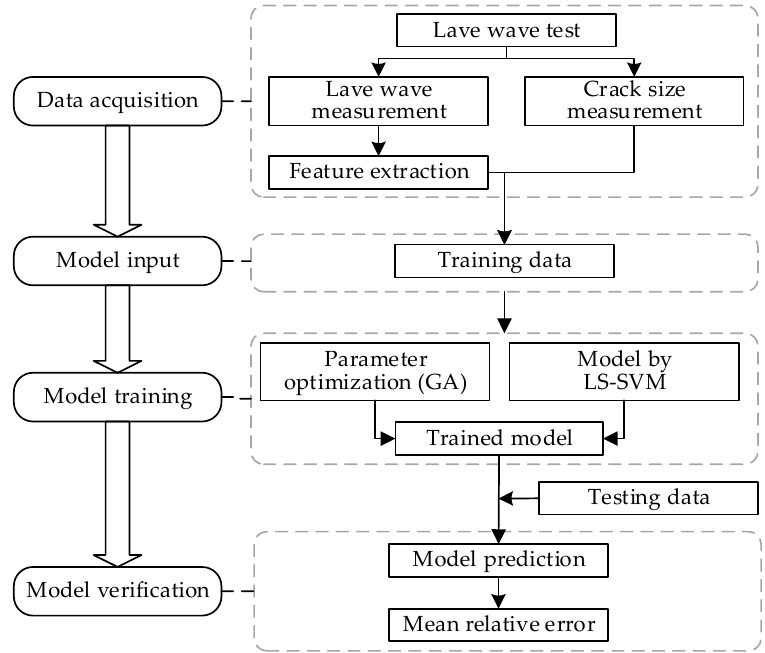
Figure 1. The overall framework of crack size quantitation using Lamb wave and genetic algorithm (GA)-based least square support vector machine (LS-SVM).